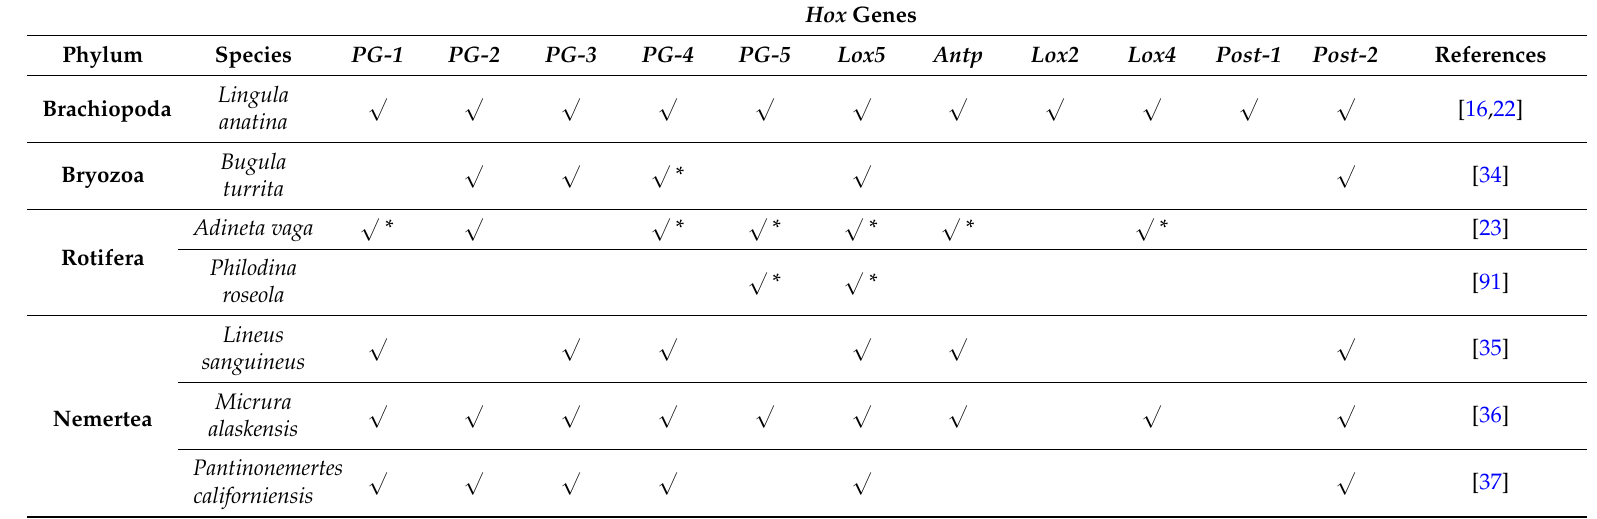
Table 1. Hox genes identified to date in Brachiopoda, Bryozoa, Rotifera, and Nemertea. Hox